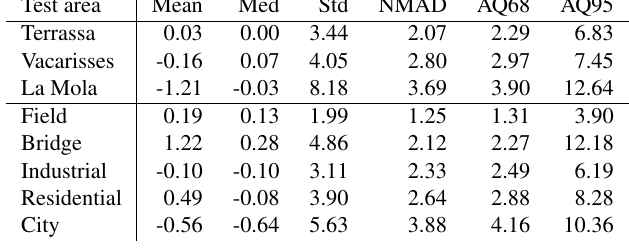
Table 3: Statistical evaluation of the euclidean distance between LIDAR reference points and the Cartosat-1 DSMs. The statistics for different landcover types were computed on the Terrassa area with the masks shown in Fig.2.